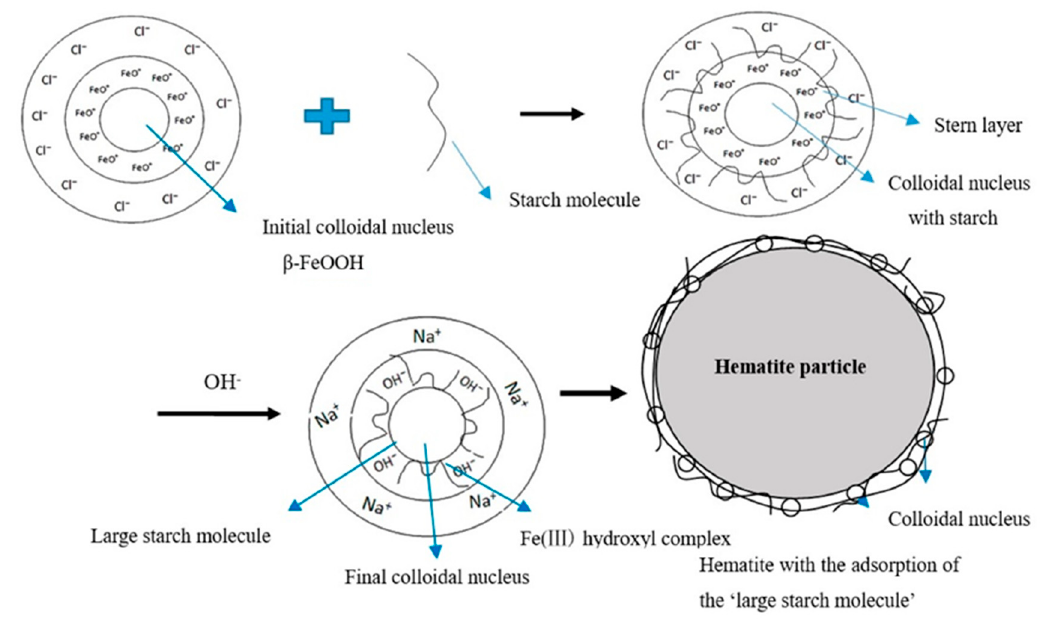
Figure 4. The proposed molecular model of the MSC (such as the Fe 3+